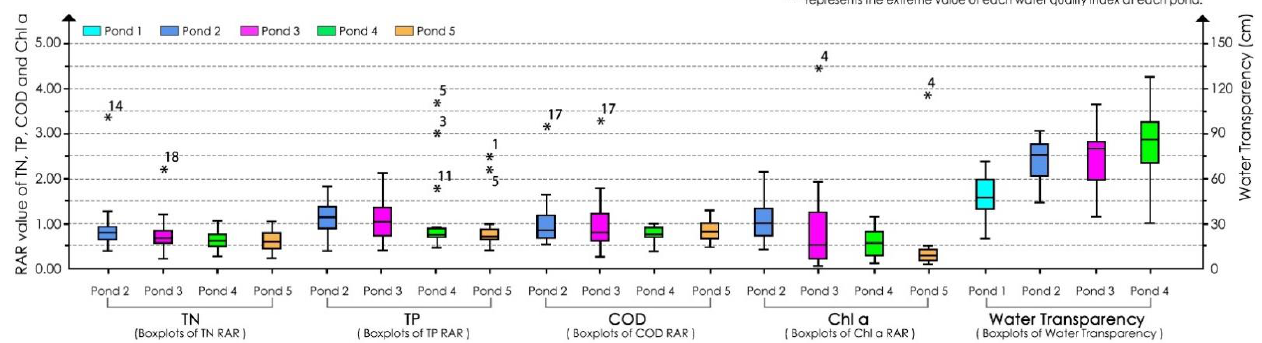
Figure A1. Boxplots of the water transparency and the RAR values of TN, TP, COD, and Chl a at each pond.